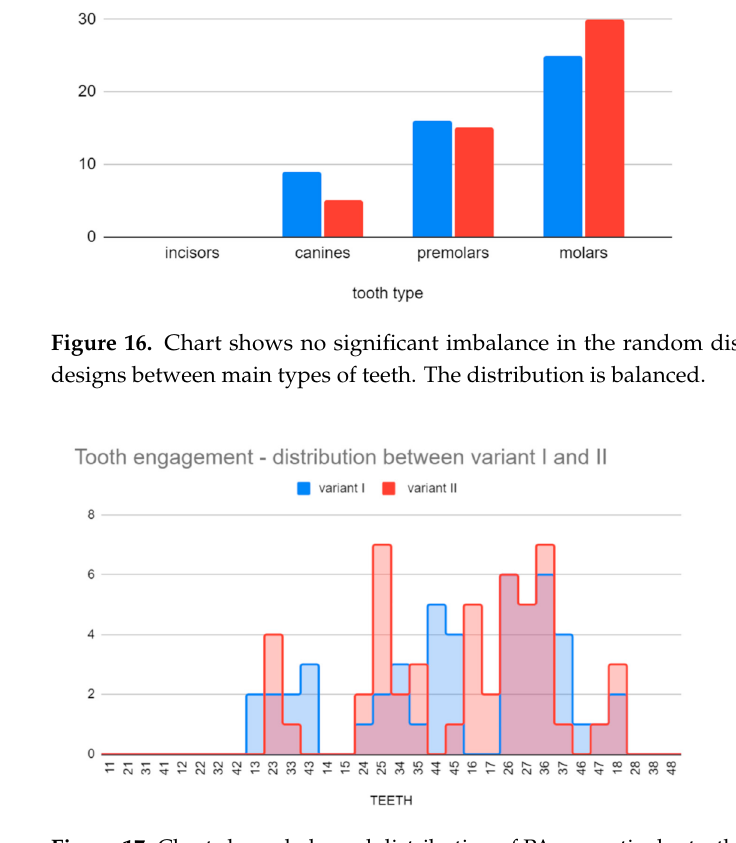
Figure 17. Chart shows balanced distribution of PA on particular teeth with obvious gaps on incisors and terminal molars (on which power-arms are rarely indicated).